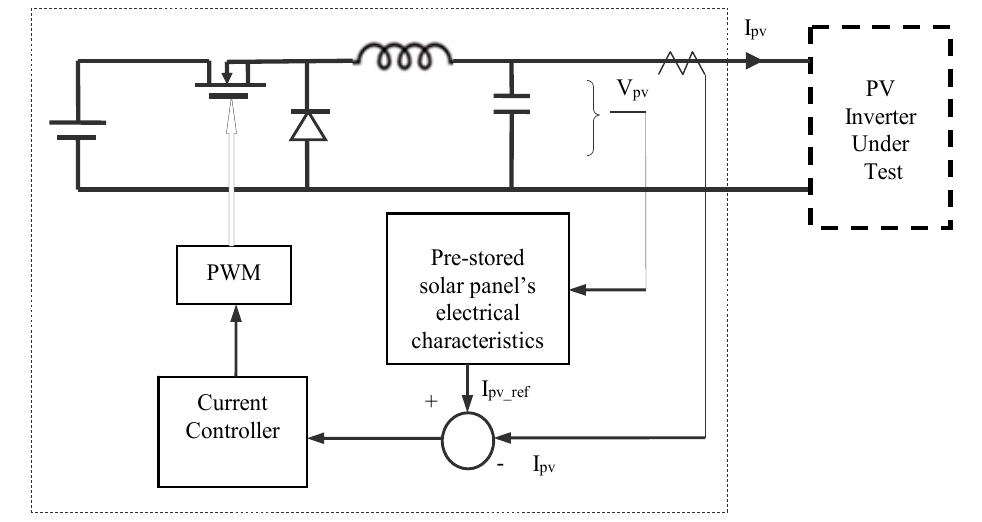
Figure 8. Buck converter circuit based PV simulator.